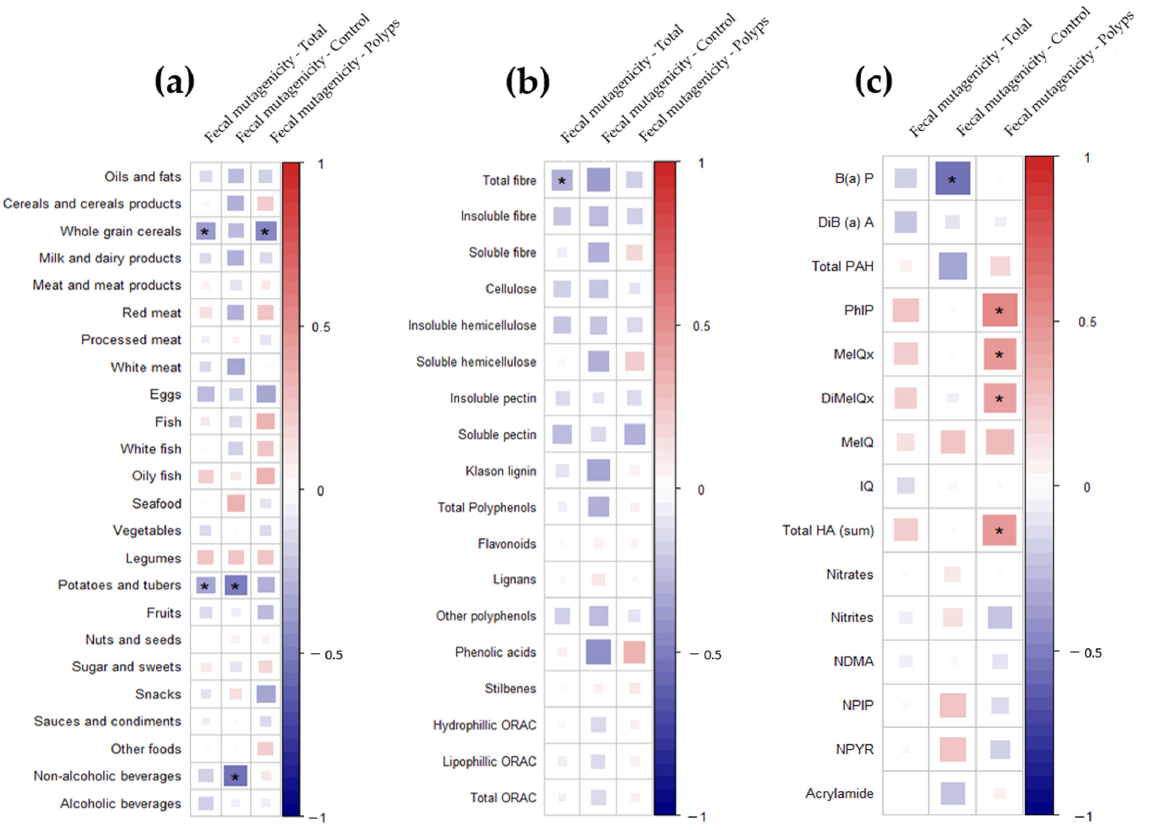
Figure 5. Heatmap defined by Spearman correlations between fecal mutagenicity and ( a ) food groups, ( b ) bioactive compounds, and ( c ) xenobiotics. Blue and red colors represent negative and positive associations, respectively. The color intensity is proportional to the degree of association between fecal mutagenicity and the factors considered. (*) p ≤ 0.05.